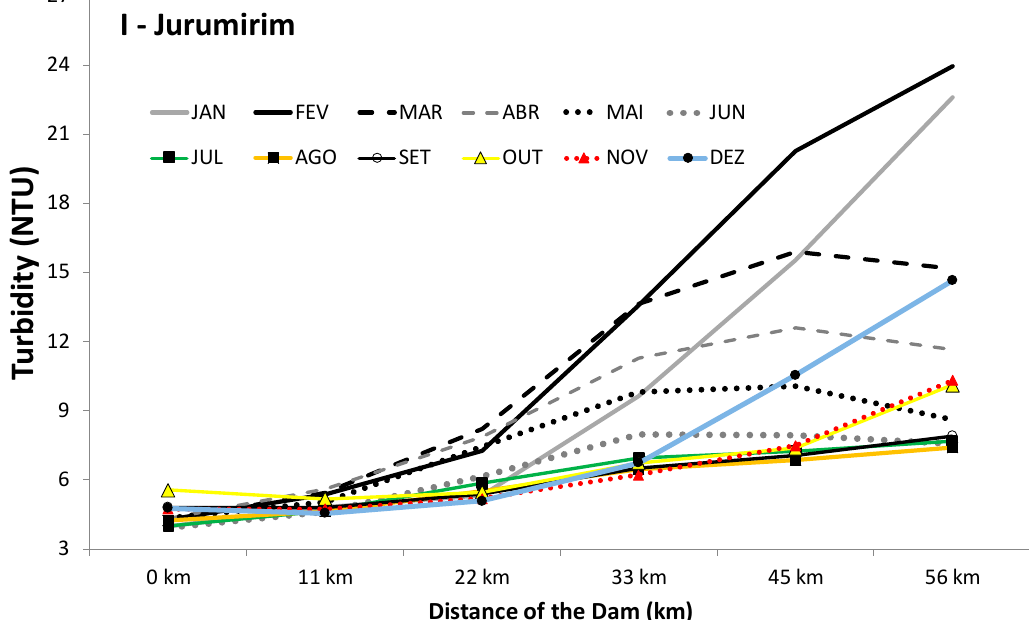
Figure 7. Monthly longitudinal variation of remote sensing-based turbidity in reservoir #1 (mean values for 2000–2013). Table 3. The mean, minimum and maximum turbidity calculated for all of the reservoirs.